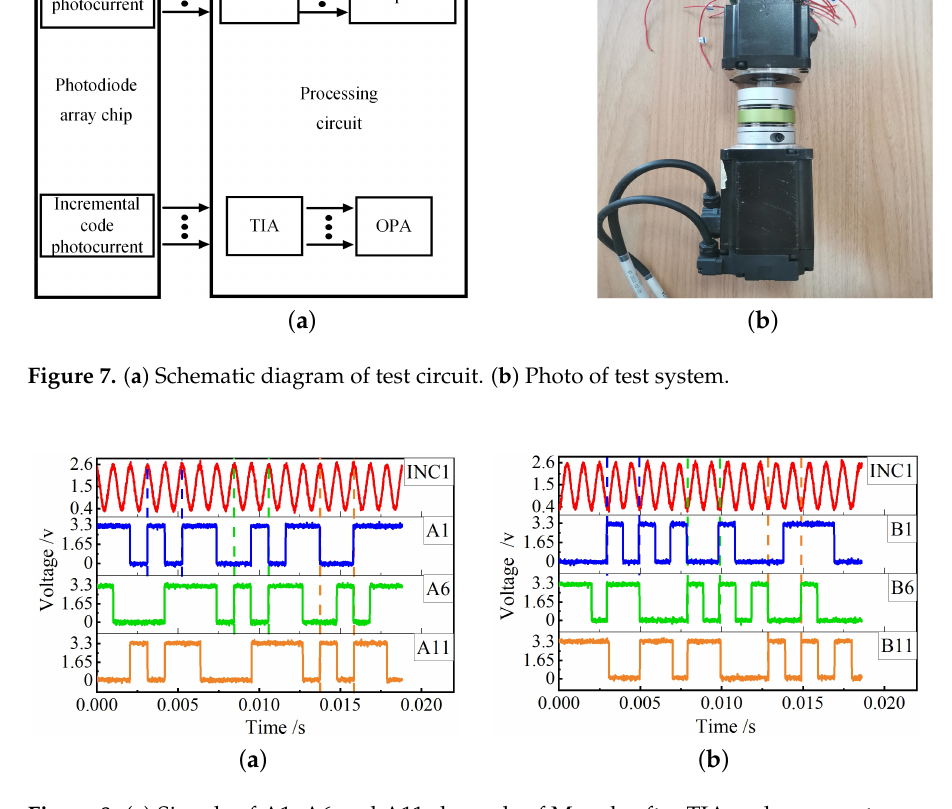
Figure 8. ( a ) Signals of A1, A6 and A11 channels of M-code after TIA and comparator processing. ( b ) Signals of B1, B6 and B11 channels of M-code after TIA and comparator